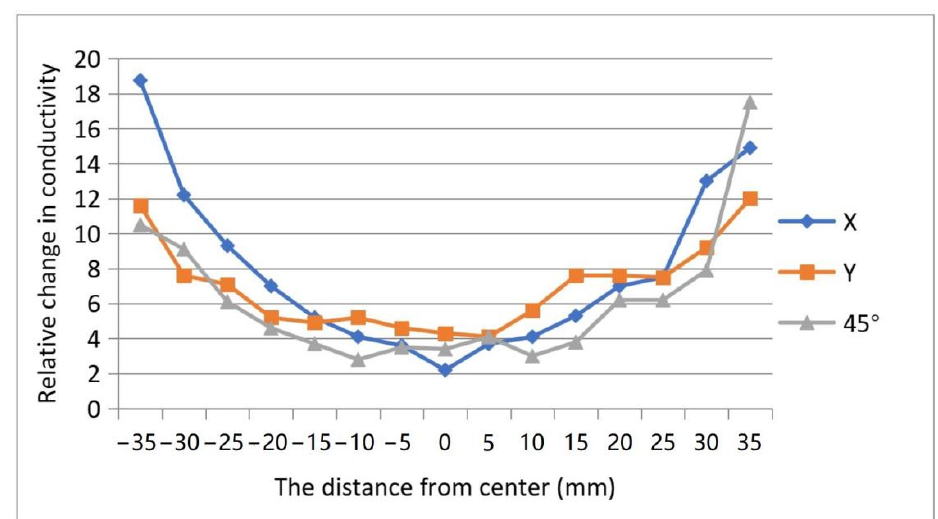
Figure 14. The sensitivity in linear direction.